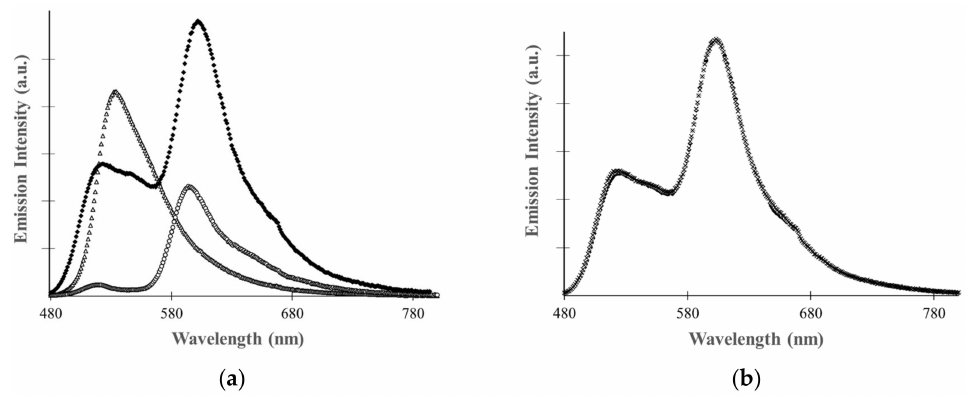
Figure 5. ( a ) Emission spectrum of CS-Fluo-TPP/HA-Rhod nanogels in PBS ( (cid:117) ), by comparison of CS-Fluo-TPP/HA ( (cid:52) ) and CS-TPP/HA-Rhod ( ) in CS-Fluo-TPP/HA-Rhod nanogels in PBS (cid:35) ( λ ex = λ D ex = 470 nm, CS-Fluo being the donor dye and HA-Rhod being the acceptor dye). ( b ) Fluo- rescence measurements of CS-Fluo-TPP/HA-Rhod nanogels ([A]/[D] ratio = 0.5) without ( (cid:117) ) and in the presence of hyaluronidase ( ×